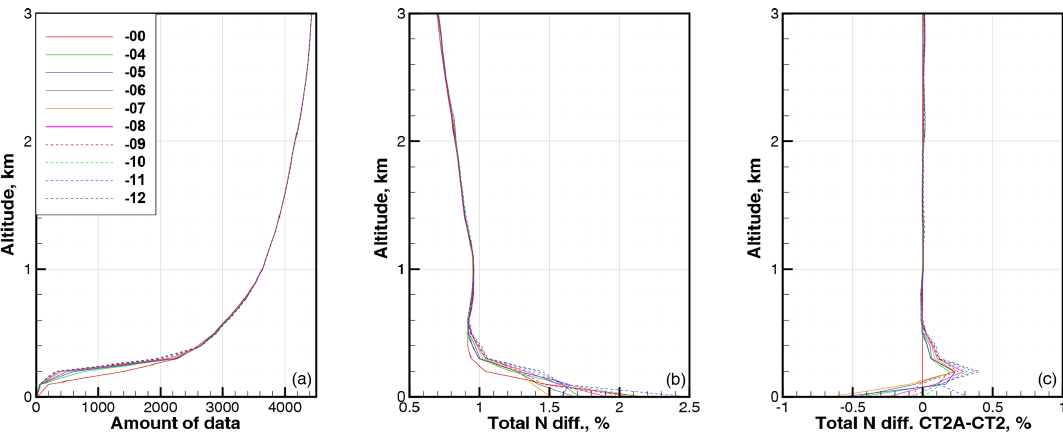
Figure 9. Statistics for latitude band 60–70 ◦ . (a) Amount of data. (b) RMS relative difference in refractivity COSMIC–ECMWF (cid:49)N CE . (c) RMS relative difference in refractivity CT2A–CT2. All are functions of the parameter β .